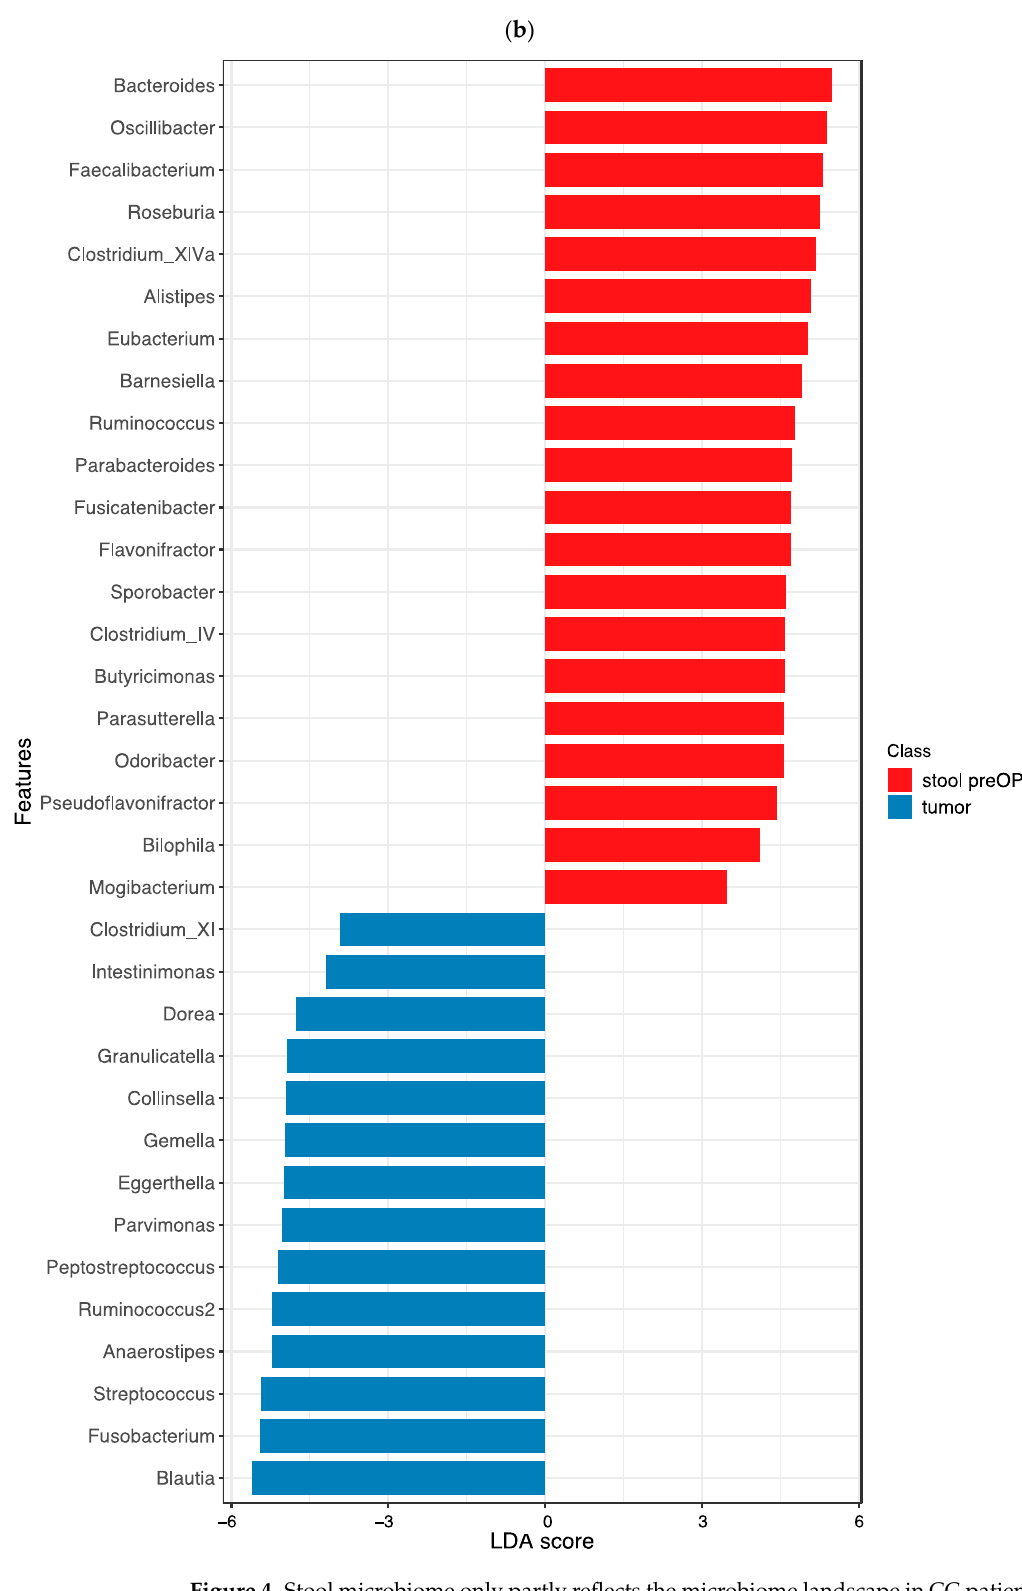
Figure 4. Stool microbiome only partly reflects the microbiome landscape in CC patients: PCoA using Jensen–Shannon divergence of beta diversity between tumor and preoperative stool, p value < 0.001 ( a ), LEfSe detected marked differences in the predominance of bacterial communities between tumor and preoperative stool, p value < 0.05 ( b